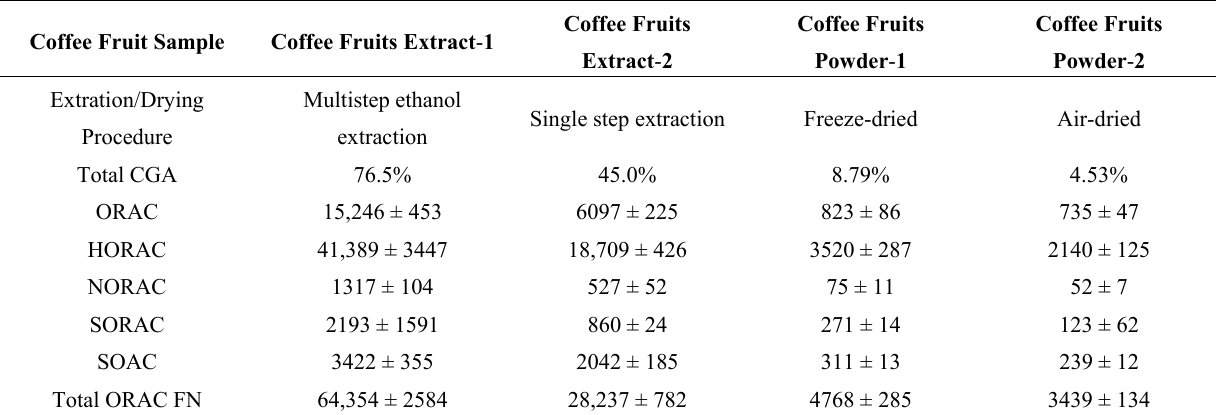
Table 1. Total ORAC activity coffee fruit sample [19]. (Note: ORAC FN results are expressed as µmole Trolox Equivalent (TE)/g ±